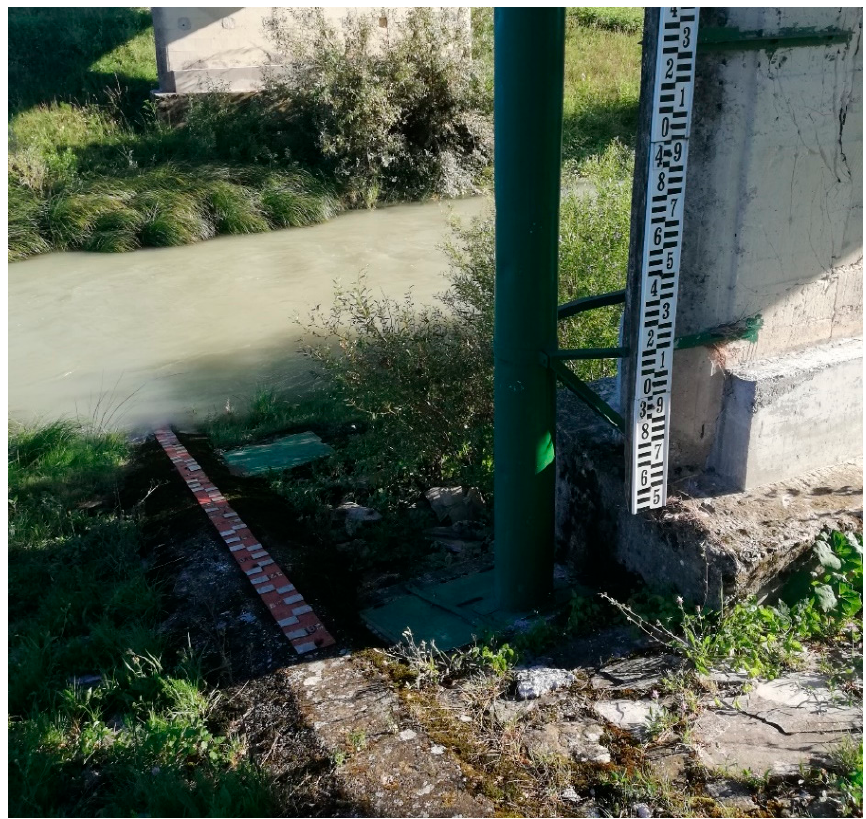
Figure A2. View of the location of the measuring station Turkovi ć i on the Gornja Dobra River.